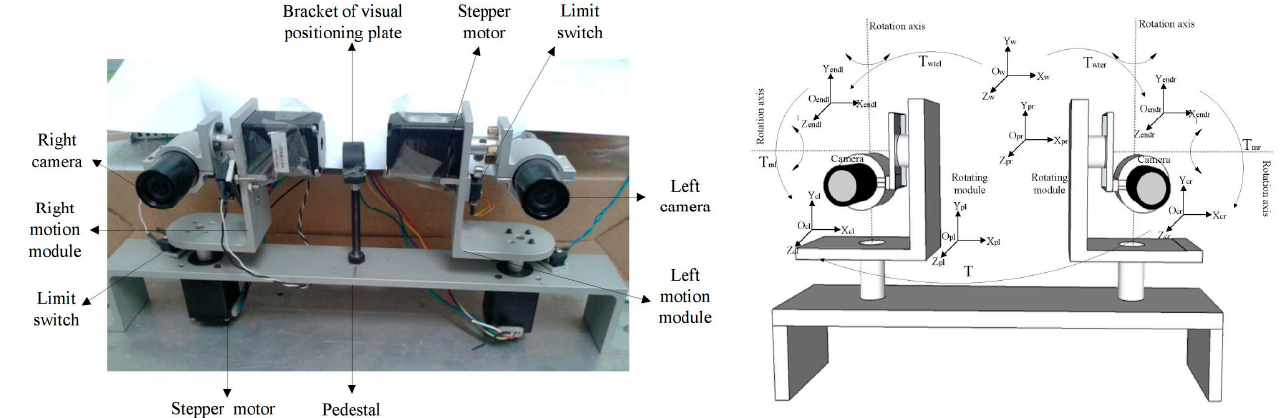
Figure 10. The bionic eye system mechanical structure and coordinate system. Copyright citation: This image is licensed by IEEE.